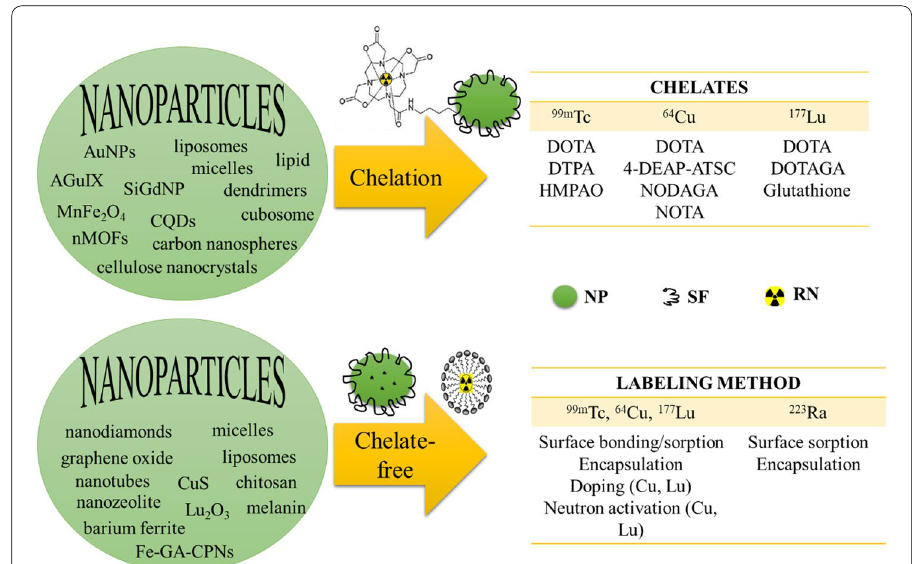
Fig. 5 Radiolabeling of nanoparticles using chelate or chelate‑free approaches. NP, nanoparticle; SF, surface functionalization; RN, radionuclide ( 99m Tc, 64 Cu, 177 Lu, 223 Ra); AuNPs, gold nanoparticles; AGuIX, gadolinium nanoparticles; SiGdNP, silica gadolinium nanoparticles; MnFe 2 O 4 , superparamagnetic manganese ferrite; CQDs, carbon quantum dots; nMOFs, nanoscale metal–organic frameworks; Fe‑Ga‑CPNs, iron‑gallic acid coordination